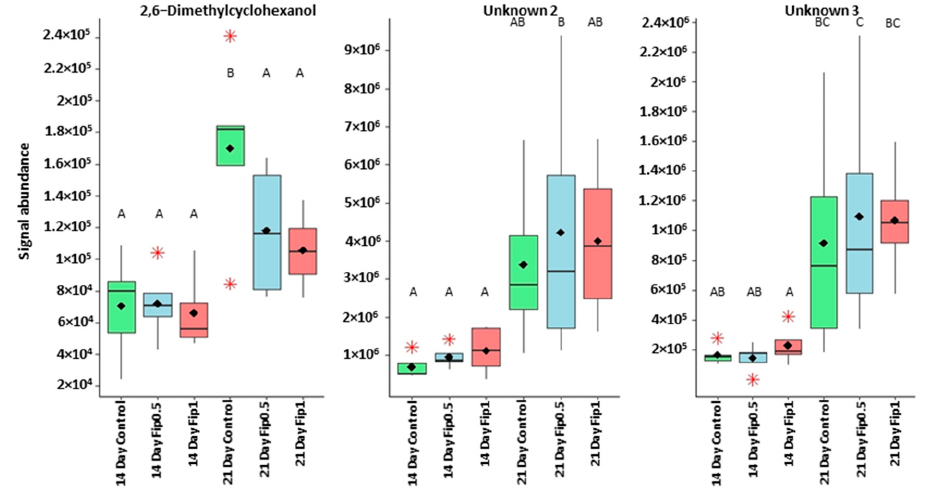
Figure 5. Boxplots representing discriminant compounds whose signal abundance increases with treatment duration irrespective of fipronil concentration. Black diamonds represent the average signal abundance of each group. The black horizontal crossbars represent the medians. Red asterisks represent outlier values. Differences in signal abundance are represented by letters. When 2 conditions are characterized by the same letter, there is no significant difference between them ( p -value > 0.05, according to a Newman–Keuls test).